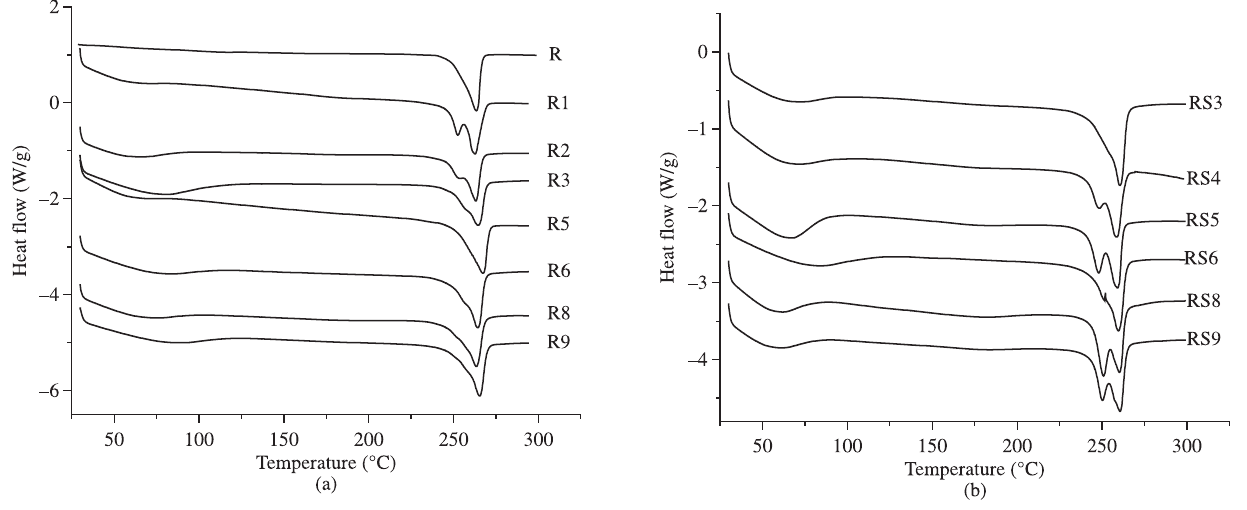
Table 8. Main thermal transitions, amount of residual solvent, X Sample